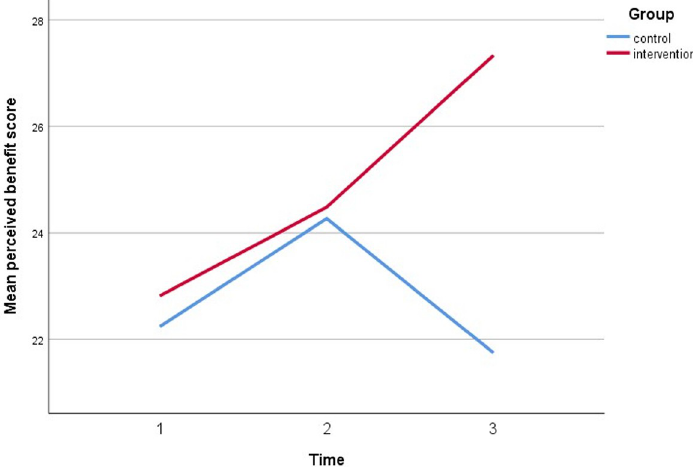
Fig 7. A plot of perceived benefit scores among respondents, showing an interaction between groups and time.